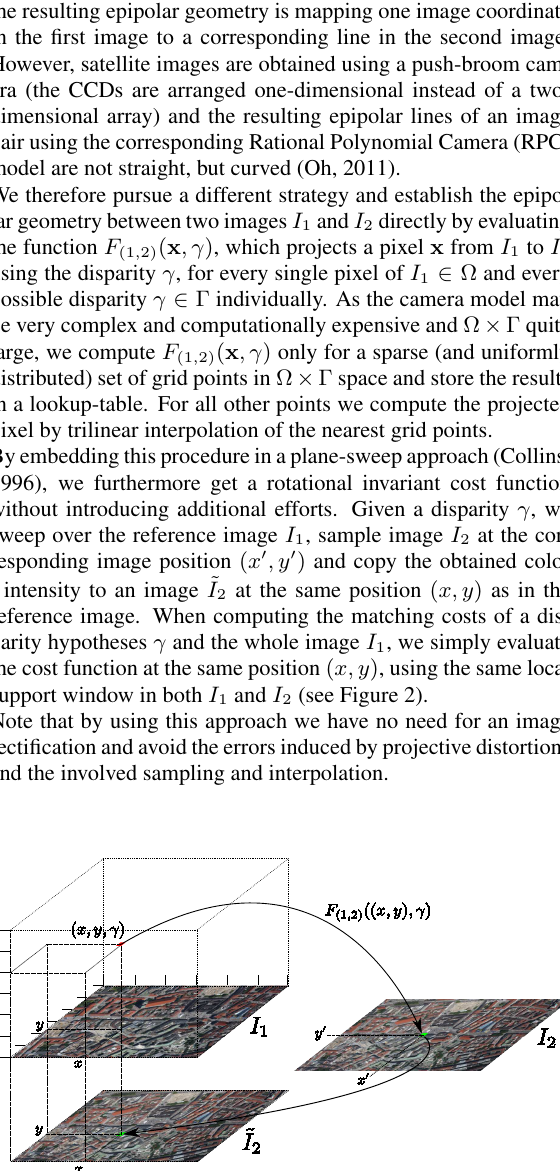
, refined camera poses C ∗ k . k